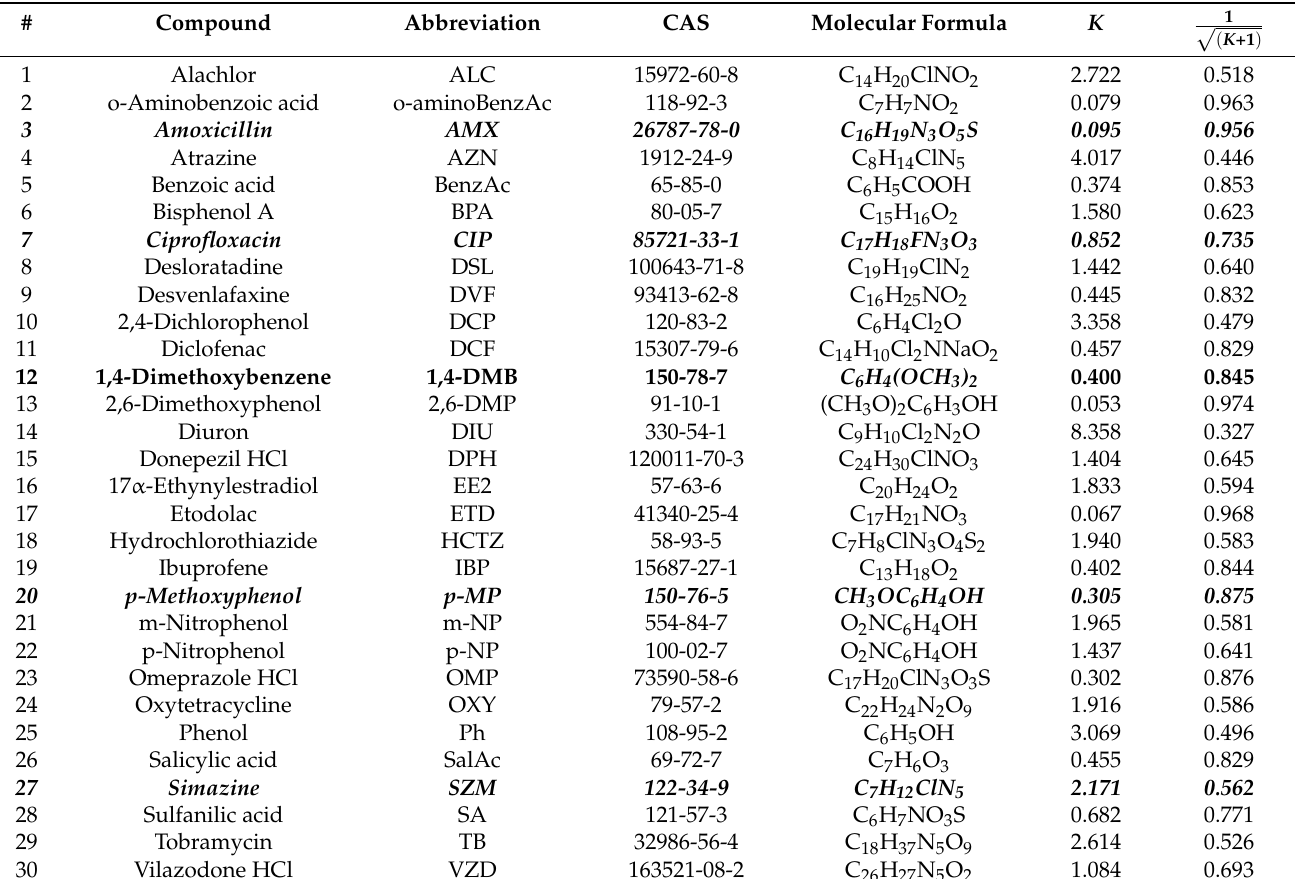
Table 1. List of 30 selected organics used in a study, along with original and transformed values of K coefficient, with included splitting into training and test set for QSA/PR